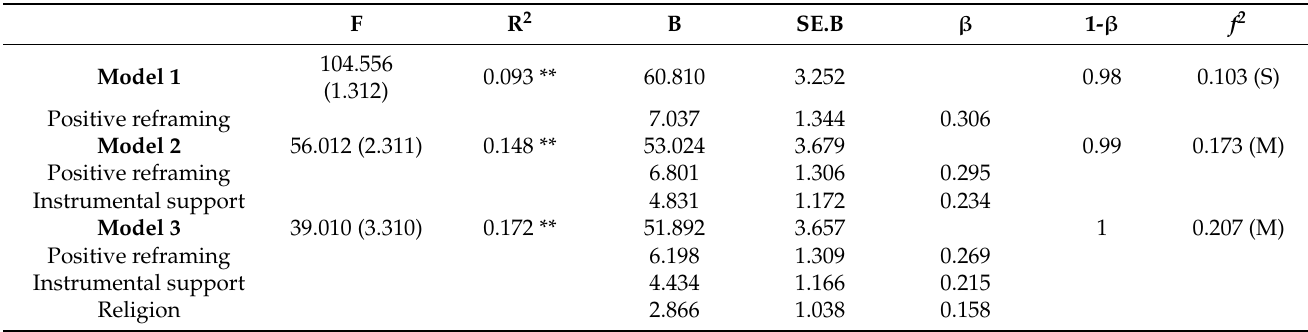
Table note: M = medium effect size, S = small effect size. Significance value ** p <